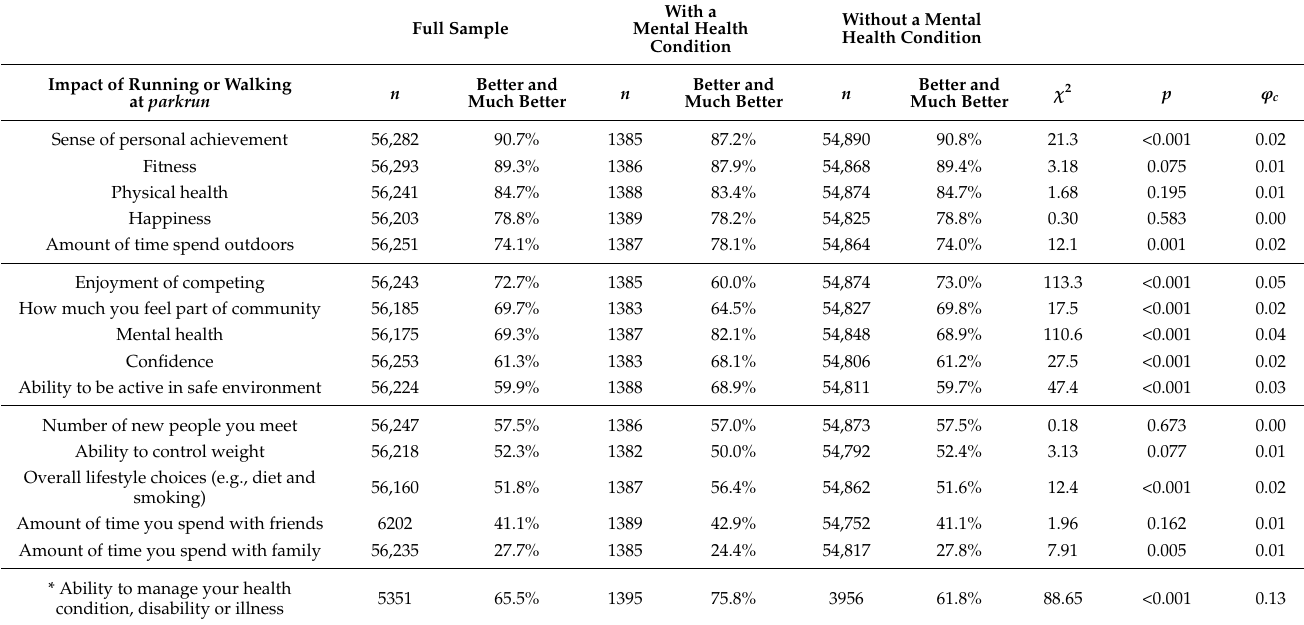
Table 5. Response to the question “Thinking about the impact of parkrun on your health and wellbeing, to what extent has running or walking at parkrun changed your/the . . . ” Proportions are for those reporting better and much better ; comparison using X 2